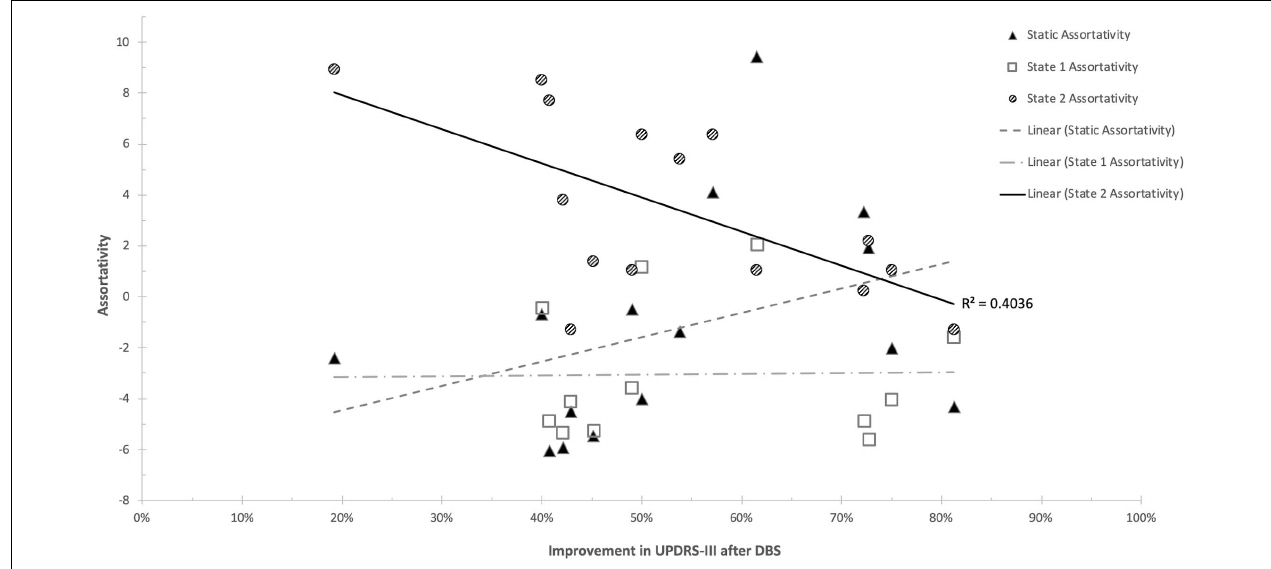
FIGURE 5 | Scatterplot of Network Assortativity and UPDRS-III improvement. Significant findings were present only in the hypoconnected state (State